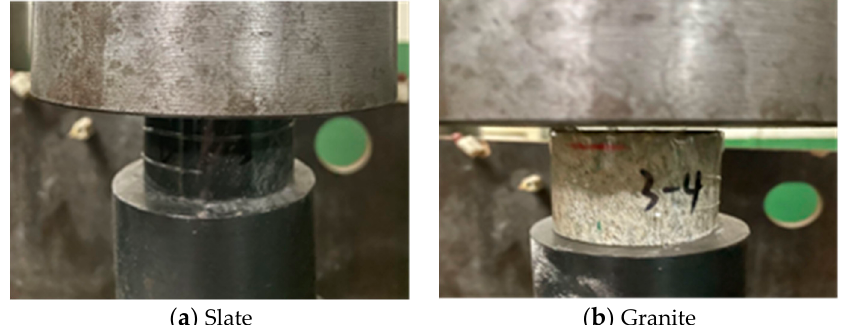
Figure 1. Brazilian splitting test.